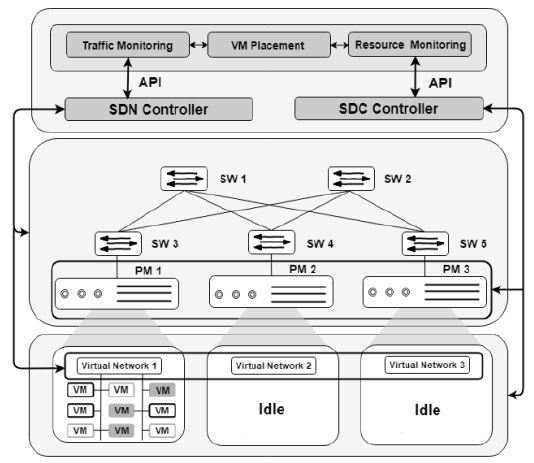
Figure 1. System